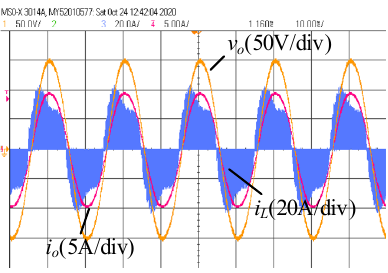
Figure 11. The voltage and current waveforms of the DCM inverter at P o = 1 kW. Time: 10 ms/div. The zoomed-in waveforms of Figure 11 at different output voltage values, including